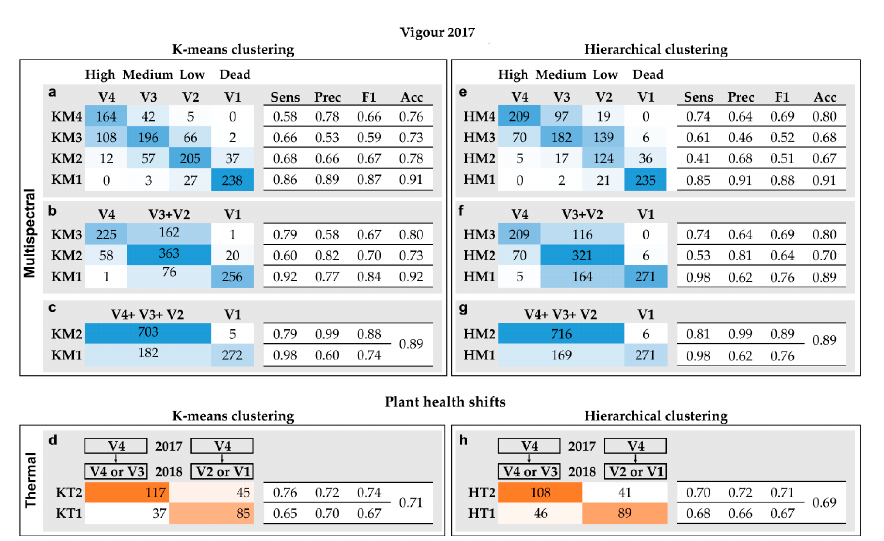
Figure 4. Confusion matrices of unsupervised clustered data for the assessment of disease spreading (plant vigour) and the prediction of future outbreak (plant health shifts). K-means ( a – c ) and hierarchical clustering ( e – g ) performance in assessing disease spreading using 4, 3 or 2 clusters, and using multispectral data. ( d ) and ( e ), performance of thermal clusters in predicting future outbreaks using 2 clusters, for K-means and hierarchical clustering, respectively. In ( b – d ) and ( f – h ) reference data were merged if the number of clusters was inferior to the number of reference classes. In ( b ) and ( f ), a class was created aggregating weakened and diseased plants (V3 and V2). In ( c ) and ( g ), the three classes with leaves (V4, V3 and V2) were grouped together. In ( d ) and ( h ), plants that remained asymptomatic until 2018 (left) were split apart from those that showed wilting symptoms in 2018 (right). Abbreviation: Sesn, Sensitivity; Prec, Precision; F1, F1-score; Acc, accuracy; KM1-KM4 and KT1, KT2 multispectral and thermal